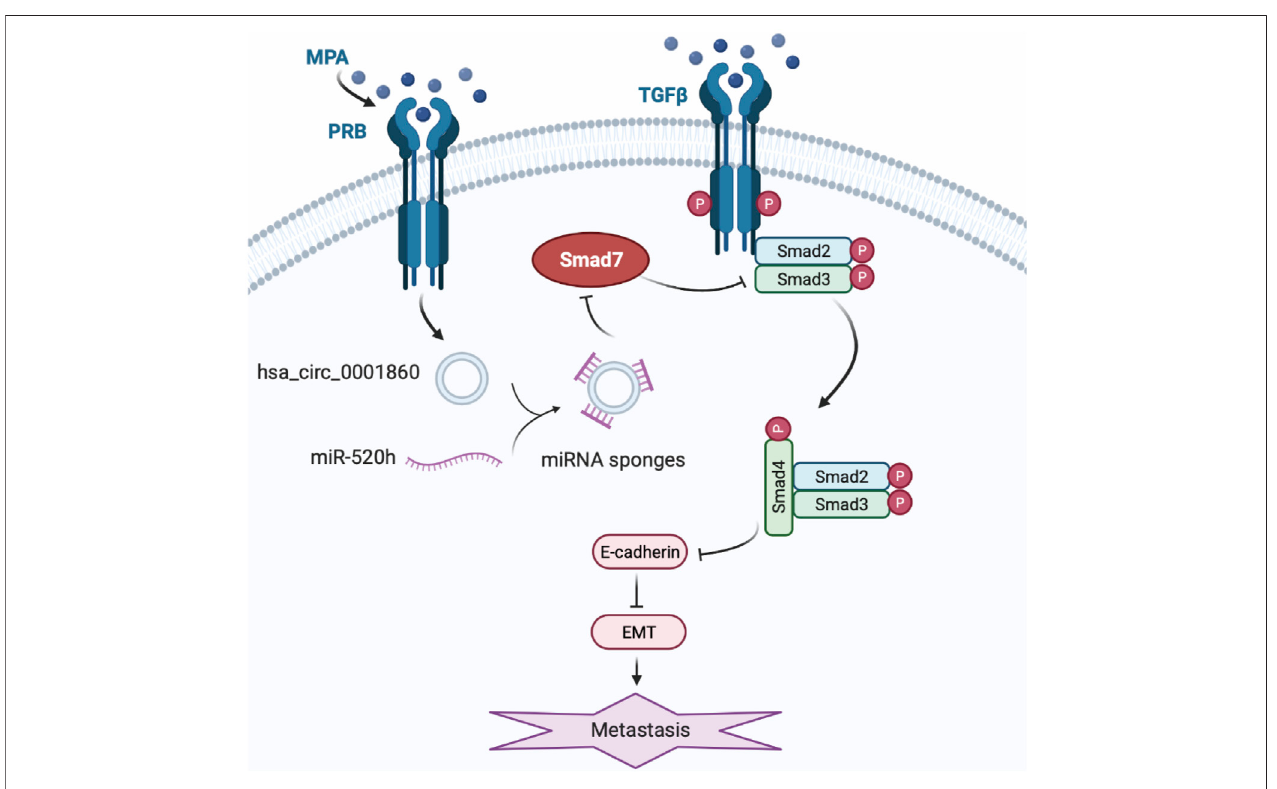
FIGURE 7 | A working model for the role of hsa_circ_0001860 in EMT of EC cells treated with MPA. The expression upregulates in EC cells treated with MPA treatment induces increase of hsa_circ_0001860, which functions as a ceRNA for miR-520h, and regulates the expression and activity of Smad7, thus inhibits phosphorylation of Smad2/3, leading to the formation of Smad2/4 complex and nuclear translocation, and enhanced E-cadherin expression. Then, increased E-cadherin inhibits the migration and invasion and EC progression through EMT.